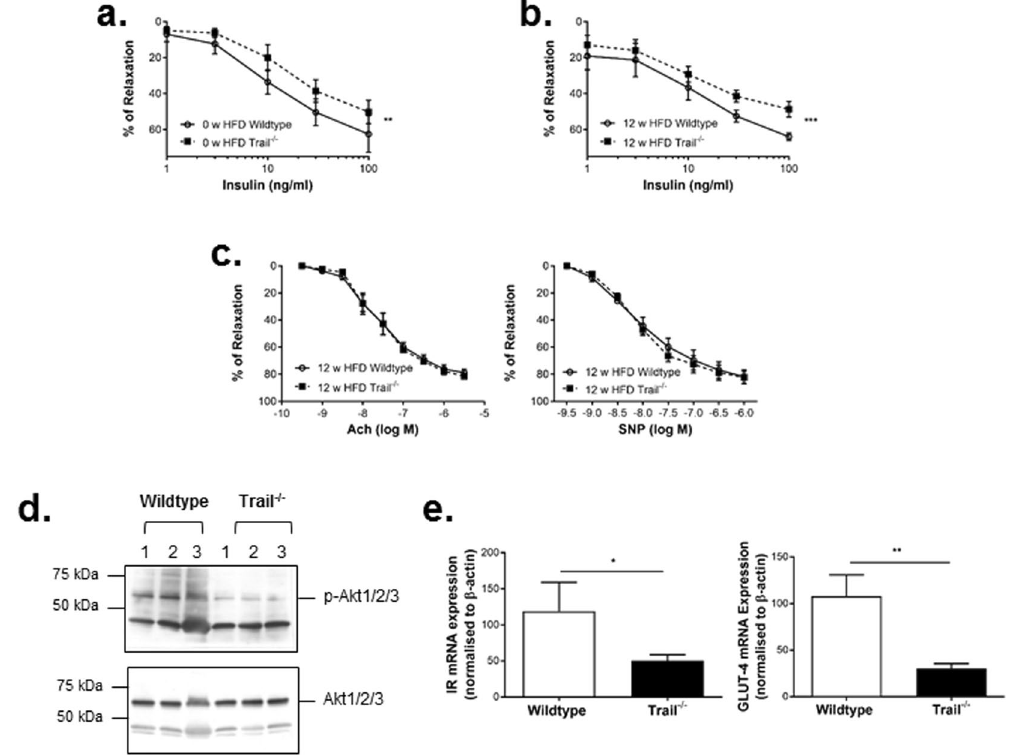
Figure 6. Trail − / − vascular tissue have altered insulin signals. Concentration-response curves for ex vivo aortic relaxation induced by insulin at ( a ) baseline 0 w HFD or ( b ) 12 w HFD wildtype and Trail − / − mice; (n = 5/ genotype). ( c ) Concentration-response curves for ex vivo aortic relaxation induced by Ach ( left ) and SNP ( right ) in 12 w HFD mice. ( d ) Aortas from 12 w HFD Trail − / − mice in response to an insulin challenge (45 min) have reduced p-Akt protein expression, with no change in total Akt levels. ( e ) Aortic mRNA expression of insulin receptor- β and GLUT-4 in 12 w HFD Trail − / − vs. wildtype; mRNA levels were normalised to β -actin (n = 3/ genotype). Results are expressed as mean ± SEM; ANOVA or Mann-Whitney U -test; * p < 0.05, ** p < 0.01, *** p <